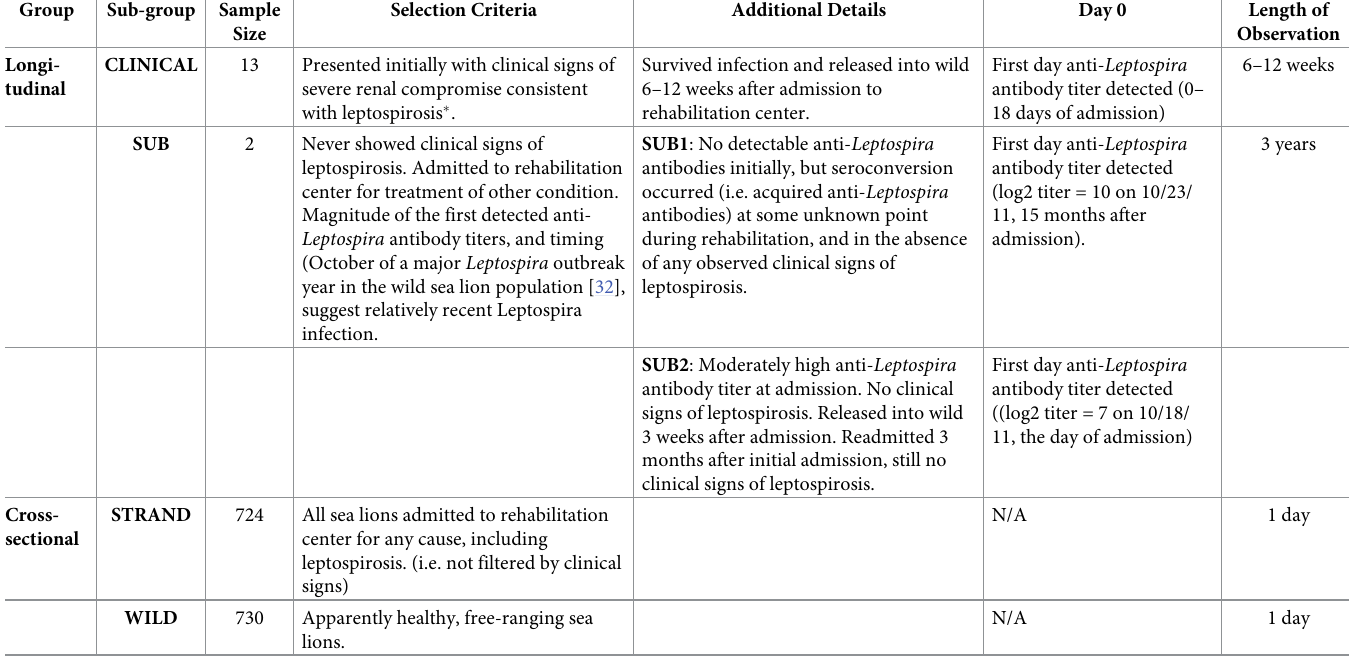
Table 2. Description of the different data sets used in our study. Columns include the category of data “Group” and “Sub-group”, the “Sample Size” of unique individu- als, the “Selection Criteria” used for inclusion, the “Additional Details” regarding individuals included, the “Day 0”, i.e. the first day for which Leptospira infection related biomarkers were tracked in an individual, longitudinally monitored sea lion, and the “Length of Observation”, i.e. the period of time over which data were collected.